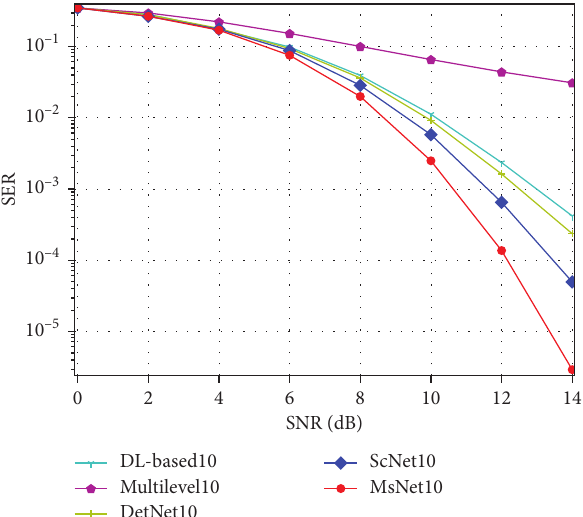
Figure 7: SER comparison of various detectors: M � 32, N � 64, and QPSK.